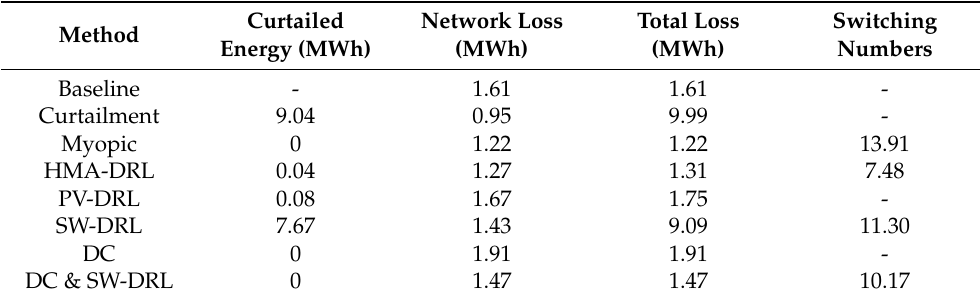
Table 3. Daily average performance comparison in terms of voltage violation, loss, and the number of switching. (HMA-DRL: the proposed heterogeneous multi-agent DRL; PV-DRL: DRL for PVSIs; SW-DRL: DRL for switches; DC: droop